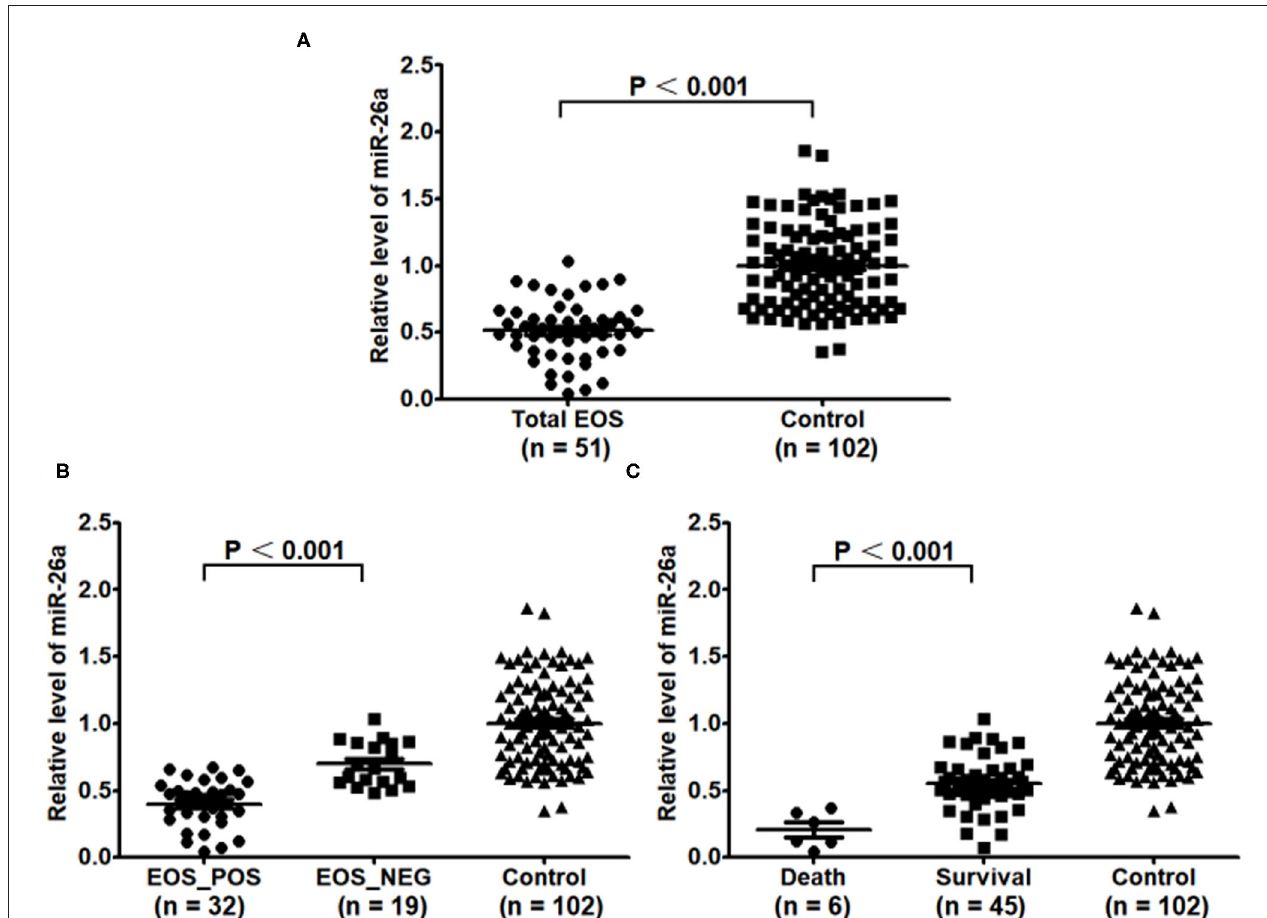
FIGURE 1 | Baseline expression of miR-26a in peripheral blood mononuclear cells. (A) Baseline expression of miR-26a in the EOS newborns and control newborns was compared. (B) Baseline expression of miR-26a in the newborns with positive hemoculture and with negative hemoculture was compared. (C) Baseline expression of miR-26a in the dead newborns and living newborns was compared. In the process, independent sample t-test was adopted, and “ P < 0.05” indicated a statistically significant difference. Total EOS, Newborns with clinical features of sepsis; EOS_POS, Newborns with positive hemoculture; EOS_NEG, Newborns with negative hemoculture.